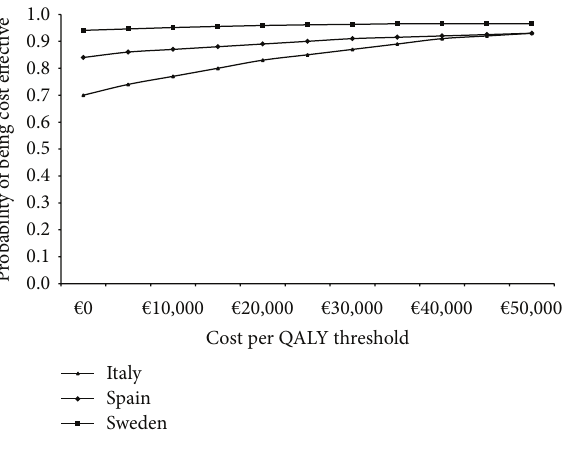
Figure 5: Acceptability